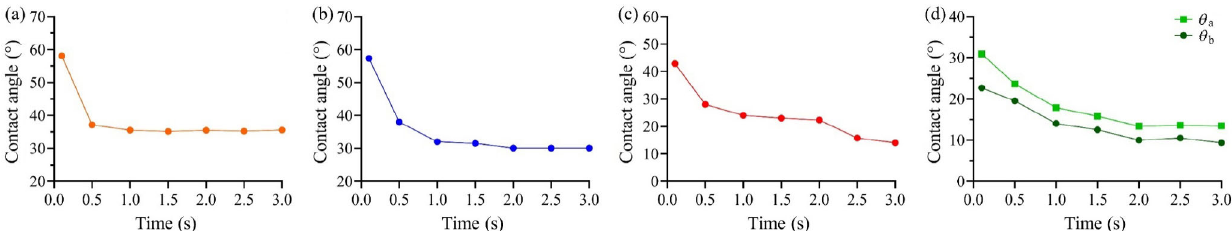
Fig. 9 Contact angle of four surfaces. (a) NB, (b) DB, (c) GB, and (d)